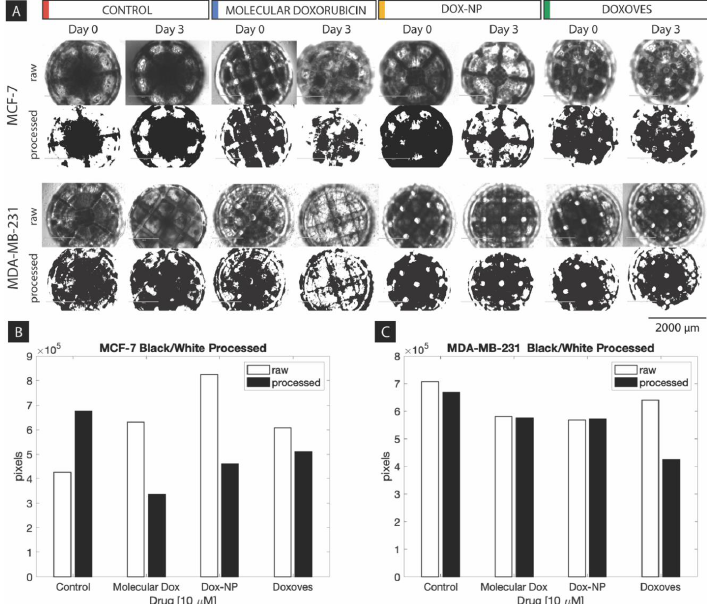
Figure 5. ( A ) EVOS Brightfield microscopic images (“raw”) and binary processed images (“processed”) using ImageJ of ultra-large (2000 µ m) MCF-7 and MDA-MB-231 spheroids cultured in Prellis Biologics sca ff olds pre- (Day 0) and post- (Day 3) treatment with DOX, Dox-NP ® , and Doxoves TM drug formulations (50 µ M). Images taken at 4x objective. (Scale bar 2000 µ m). Below are graphical presentations of ( B ) MCF-7 and ( C ) MDA-MB-231 binary processed images shown in ( A